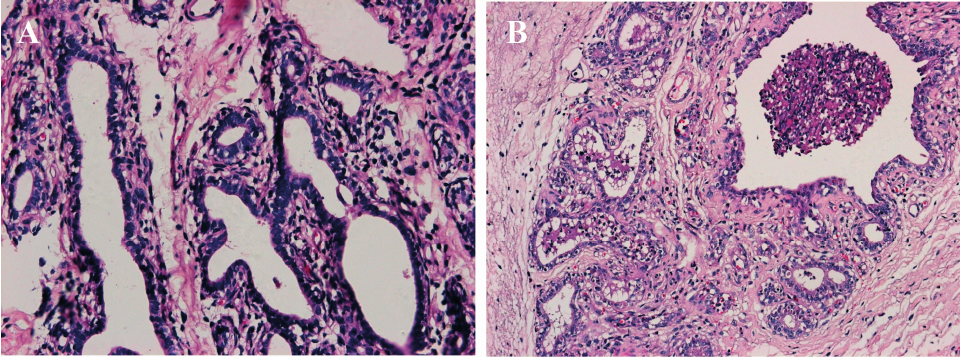
Figure 1. HE staining of mammary glands tissue (400×). ( A ) Control group; ( B ) S. aureus